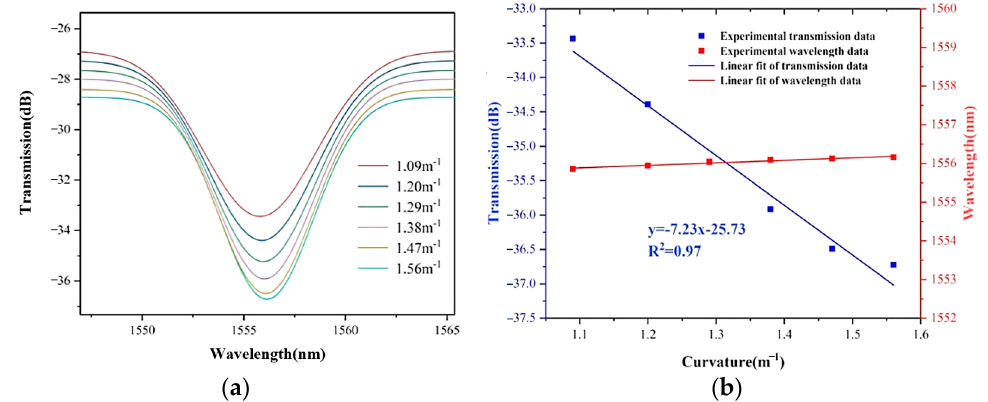
Figure 9. ( a ) The intensity Gaussian fit at the resonant wavelength from 1.09 m − 1 to 1.56 m − 1 ; ( b ) The linear fit of the resonant wavelength about the sensitivity of − 7.23 dB/m − 1 . As for the temperature measurement, we put the sensor into a variable temperature groove by controlling the TEC module from 20 °C to 80 °C. In order to more intuitively measure the sensitivity of MZI and anti-resonance effect to temperature in the fiber line, the variation in part of the spectrum with the temperature at different temperatures is intercepted. Figure 10a shows the temperature drift of a certain MZI wavelength in the range of 1532 ~ 1535 nm. It can be seen from arrows of different colors in the figure. The interference dip shifts to the long wavelength direction with increasing temperature. Figure 10b shows the linear fitting of eight groups of data points, and the results show that the temperature sensitivity is 28.8 pm/°C.